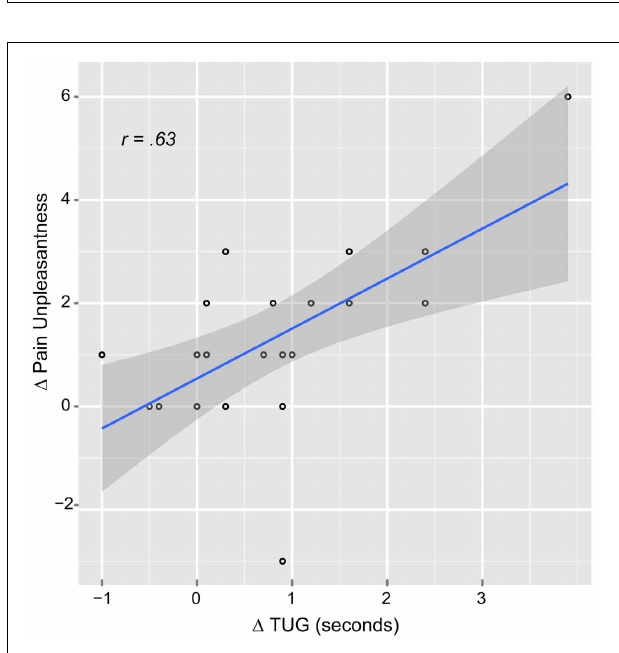
FIGURE 4 | Scatter plot of the relationship between pain unpleasantness and functional mobility difference scores in the music condition. (cid:2) , pre-post auditory stimulus; TUG, Timed up and go task.